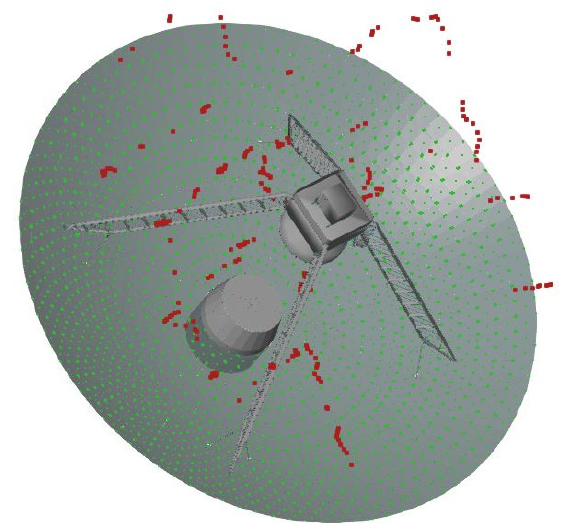
Figure 4: Positions of cameras (red dots) for Scenario A. Targets are represented on the surface of the primary mirror as green dots. of targets, as shown in Figure 5: the error is constantly lower in AICON 3D Studio with respect to MicMac. Moreover, in